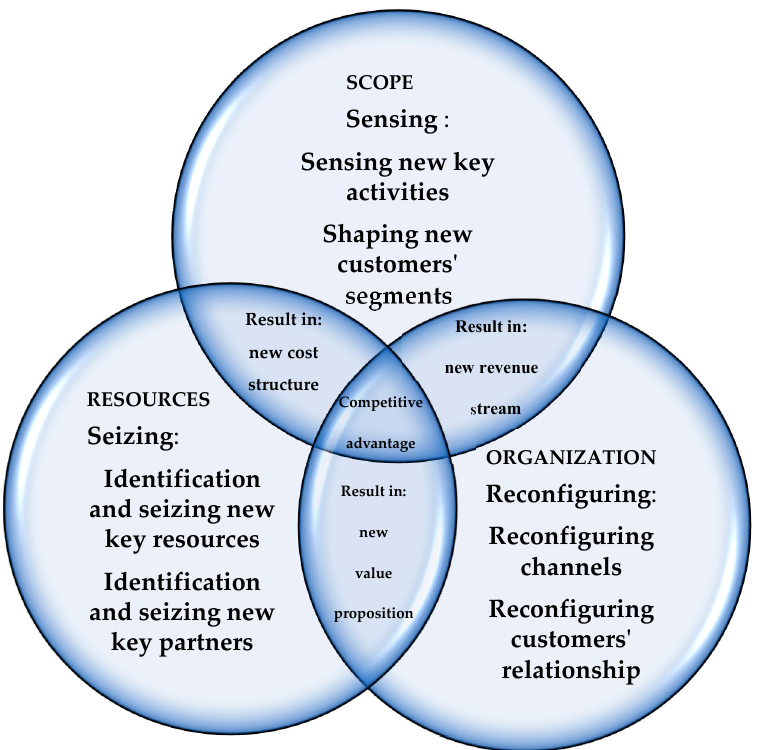
Figure 2. Integration of dynamic capabilities framework and a reinvention of business model’s components in the process of mergers & acquisitions: a conceptual model for a future research (Source: Developed by author).